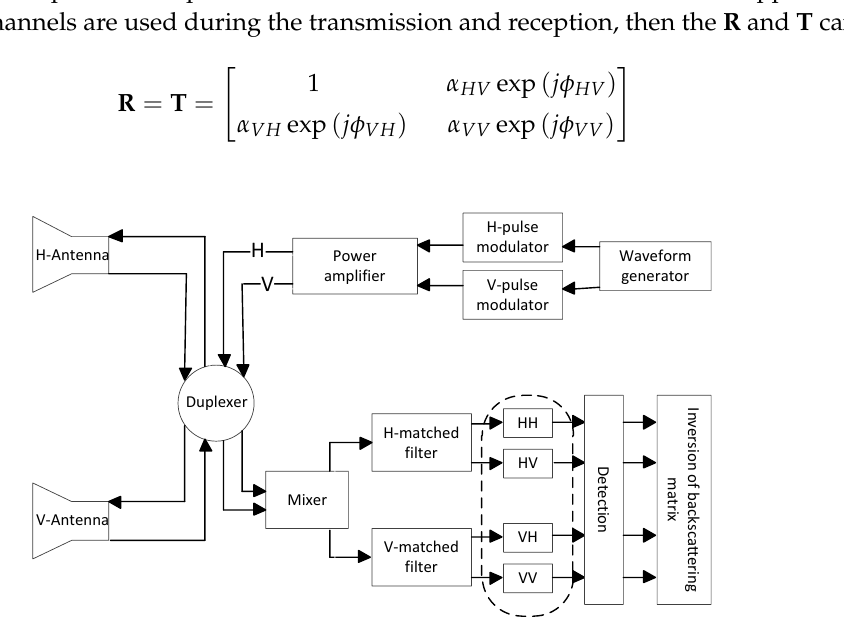
Figure 1. The signal processing flow chart of the STSR